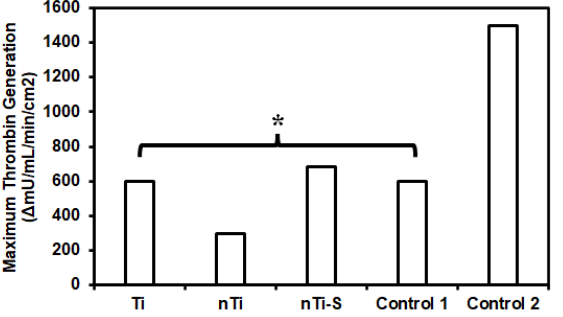
Figure 6. Highest thrombin generation velocity of plasma incubated with different surfaces between two points. (* p < 0.05, n min = 9)